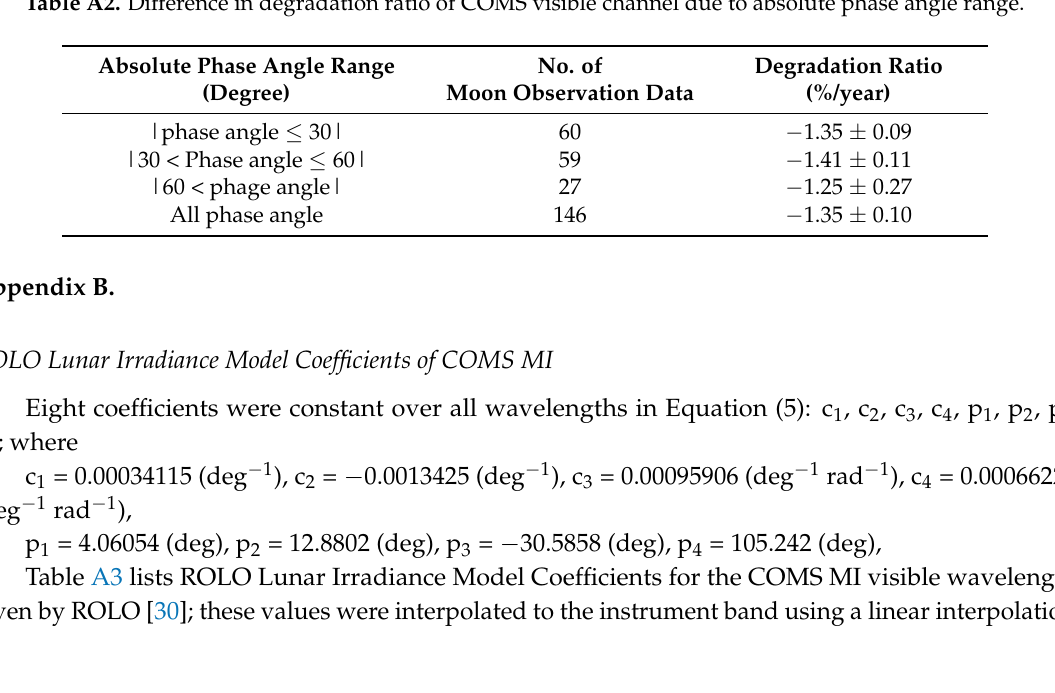
Table A3 lists ROLO Lunar Irradiance Model Coefficients for the COMS MI visible wavelength given by ROLO [30]; these values were interpolated to the instrument band using a linear